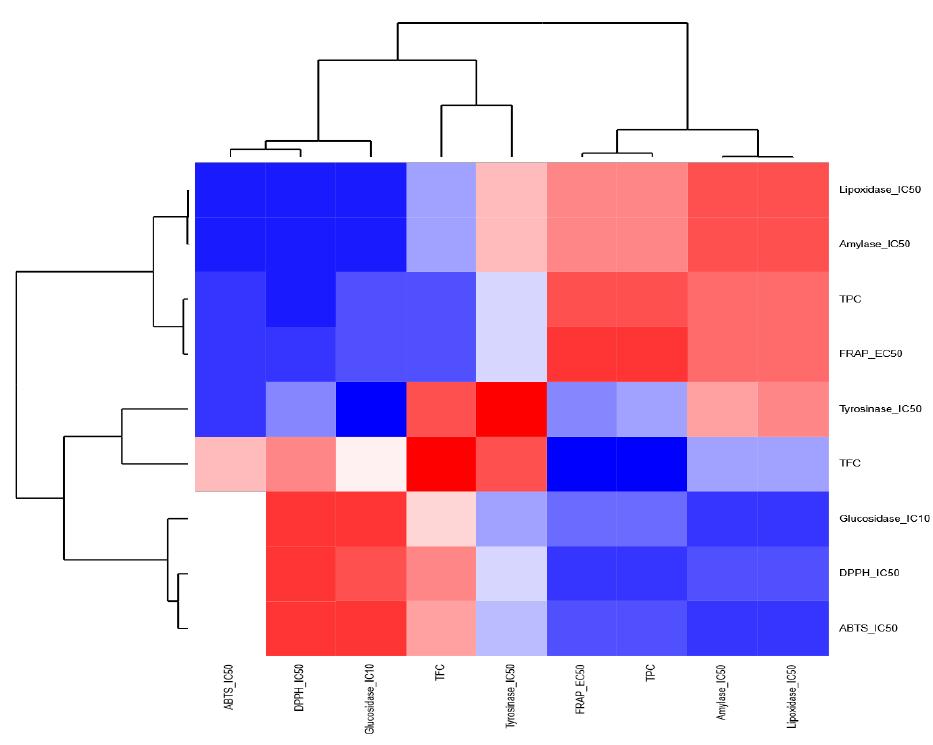
Figure 6. Heatmap highlighting the relationships among the chemical screenings within the meth- anolic extract of bark.